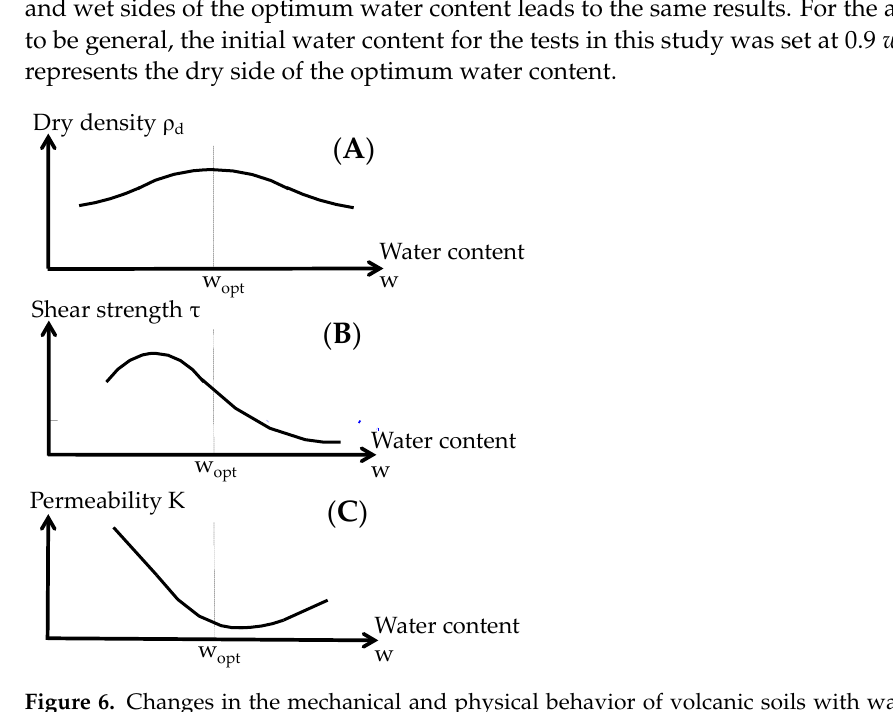
Figure 6. Changes in the mechanical and physical behavior of volcanic soils with water content ( A ) dry density, ( B ) shear Strength, ( C ) and permeability [30].